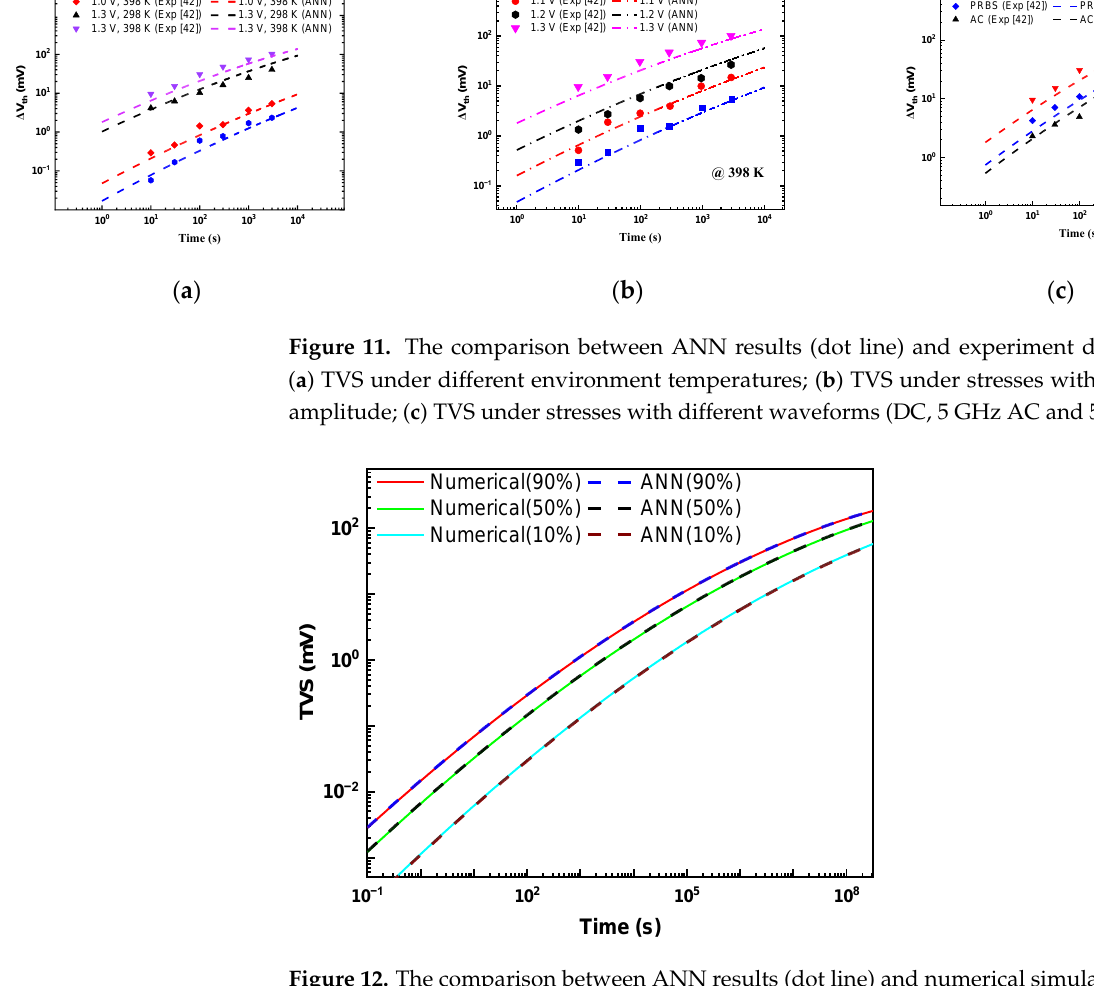
Figure 12. The comparison between ANN results (dot line) and numerical simulation results (solid line) under 10 years of stress voltage with different duty cycles [33].